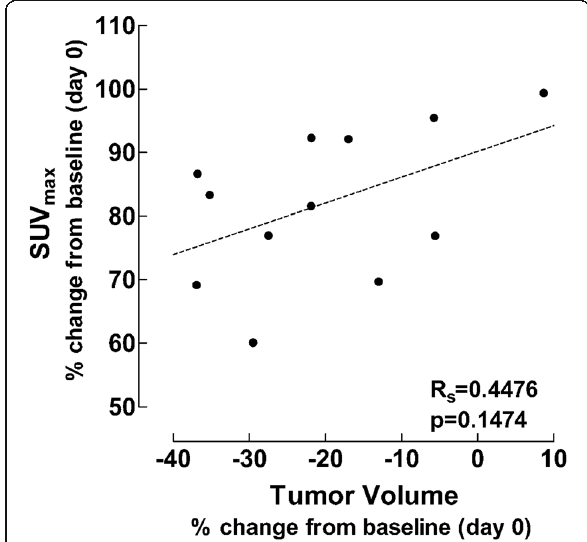
Fig. 3 Scatter plot showing the relationship between the ( R )-[ 11 C]PAQ SUV max values and the MRI-derived mammary tumor volume changes (percentage of change to baseline) in the B20-4.1.1/PTX treatment group only. Spearman ’ s rho=0.45, p